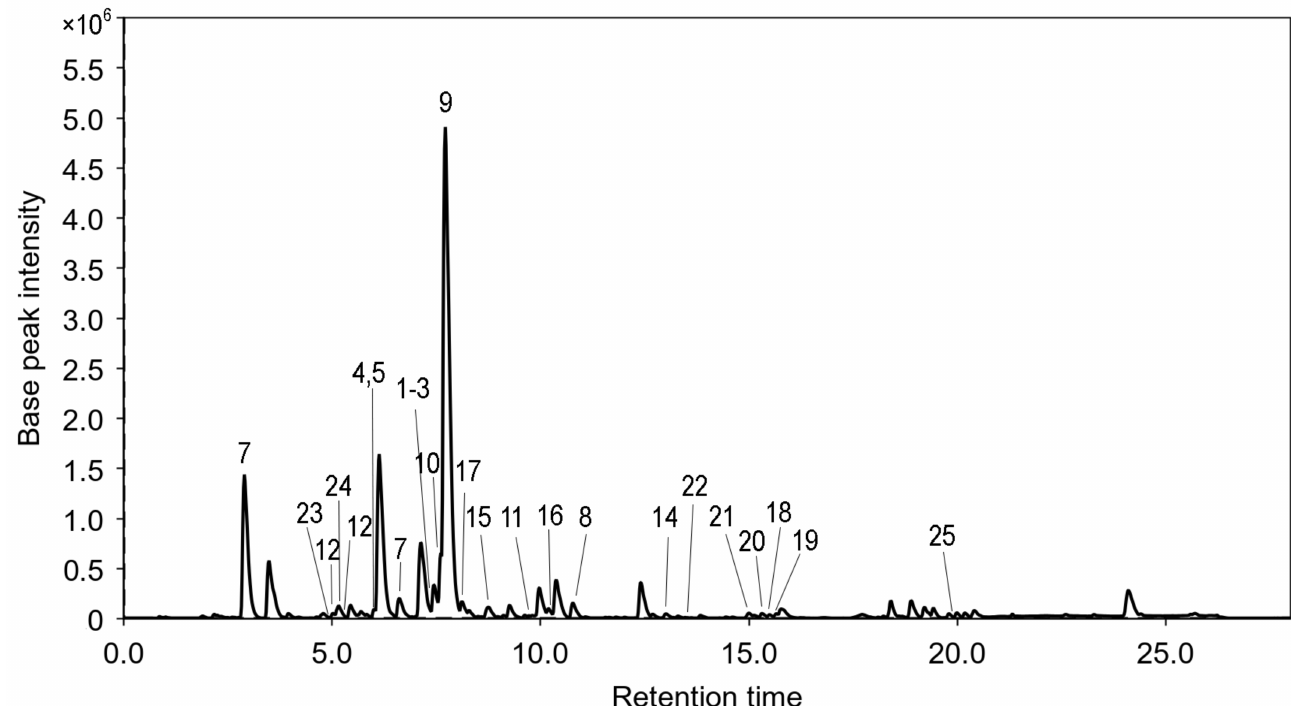
Figure 4. UHPLC MS chromatogram of extract